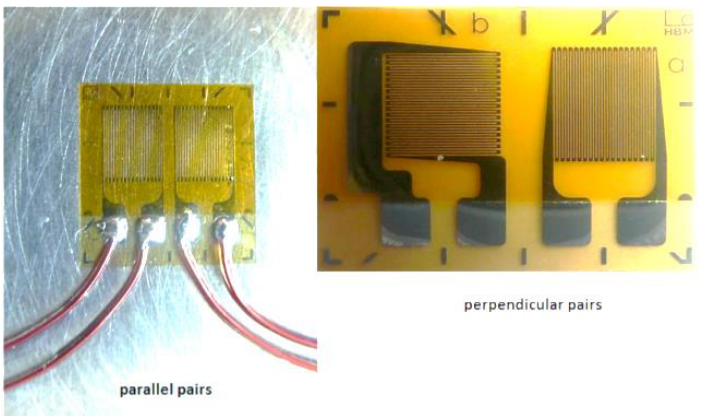
Figure 2. Examples of strain gauges. Left: the metallic foil pattern, is arranged in parallel; right: the metallic foil patterns of the two strain gauges are arranged perpendicular to each other (image from [14].